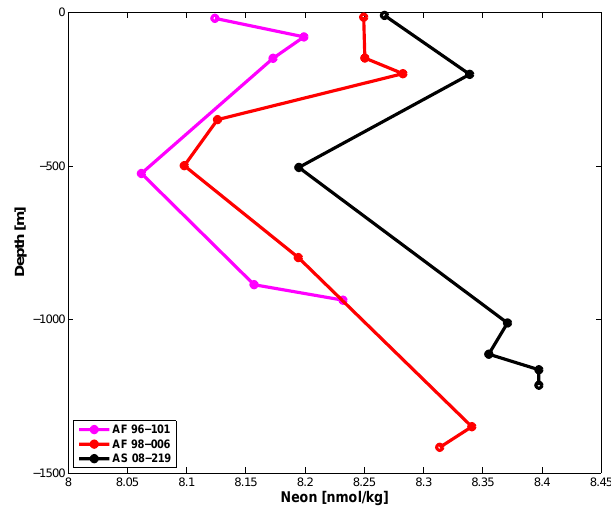
Fig. 10. Ne [nmolkg − 1 ] profiles from repeat stations in close prox- imity on the continental slope (1000–1400m depth, magenta circle in Fig. 2) in the northwestern Weddell Sea slightly northeast of the AW 06 stations in austral summers of 1996 (purple), 1998 (red), and 2008 (black). Ne concentrations increase systematically over the whole water column by roughly 0.1nmolkg − 1 per